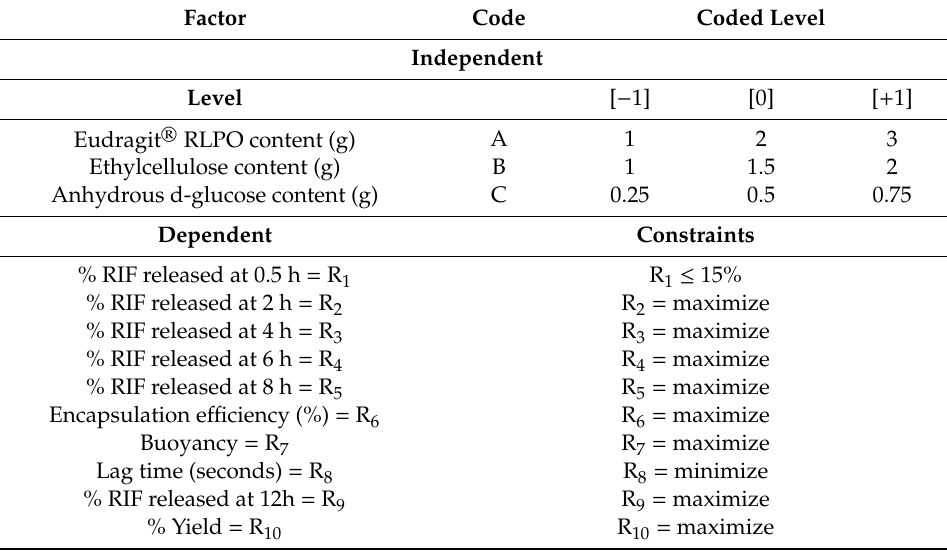
Table 2. Input variables (coded) and responses monitored for the Box-Behnken Design. Factor Code Coded